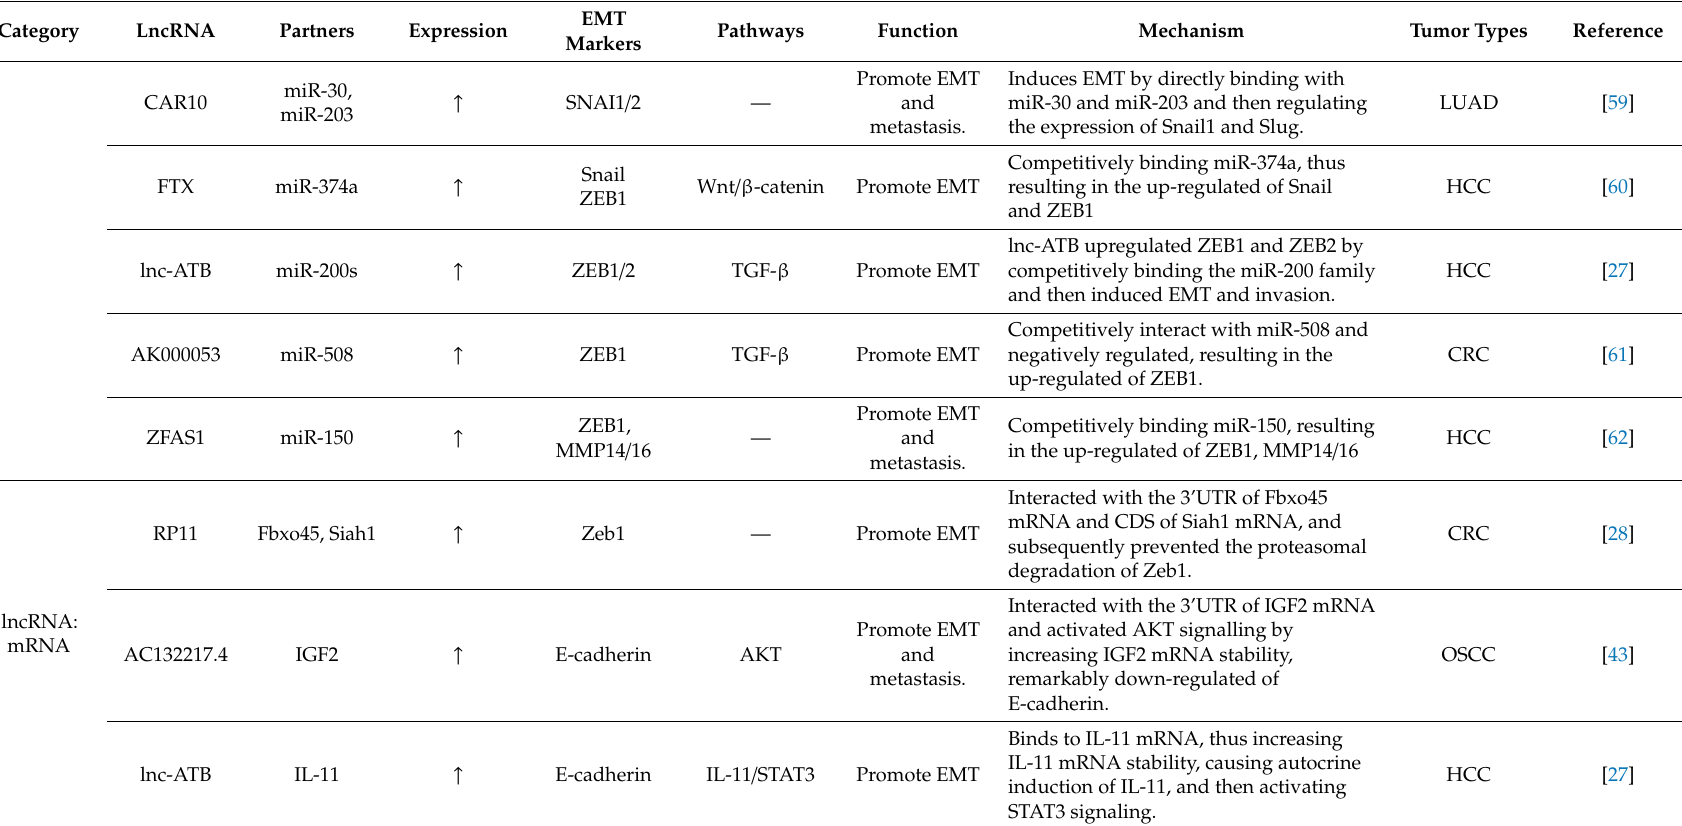
RCC: renal cell carcinoma; BC: breast cancer; HNSCC: head and neck squamous cell carcinoma; HCC: hepatocellular carcinoma; OSCC: oral squamous cell carcinoma; hESCs: human pluripotent stem cells; ESCC: esophageal squamous cell carcinoma; NSCLC: non-small cell lung carcinomas; TNBC: triple-negative breast cancer; LUAD: Lung adenocarcinoma; PADC: pancreatic ductal